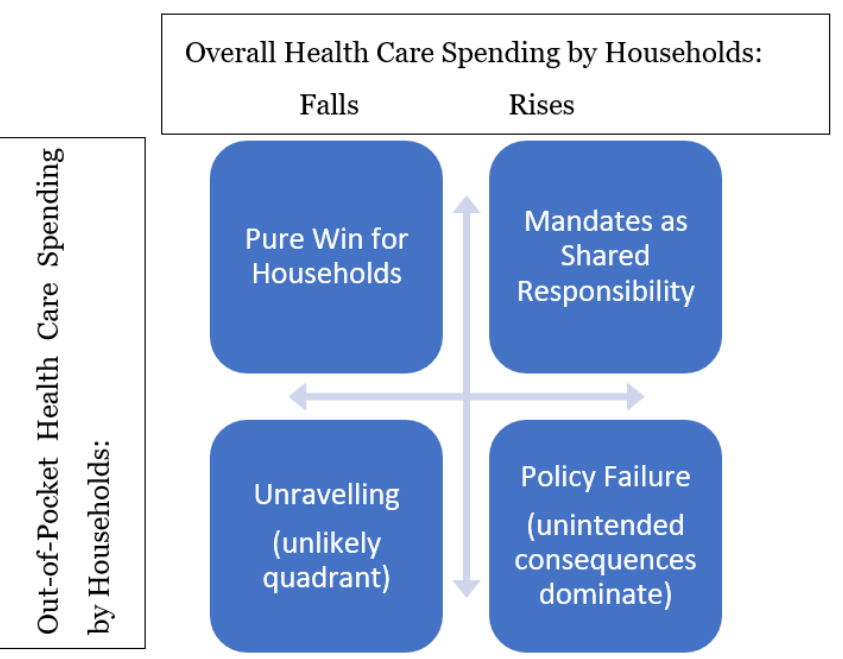
Figure 3. Potential effect of mandated benefits on out-of-pocket and overall health care spending. Source: created by author.